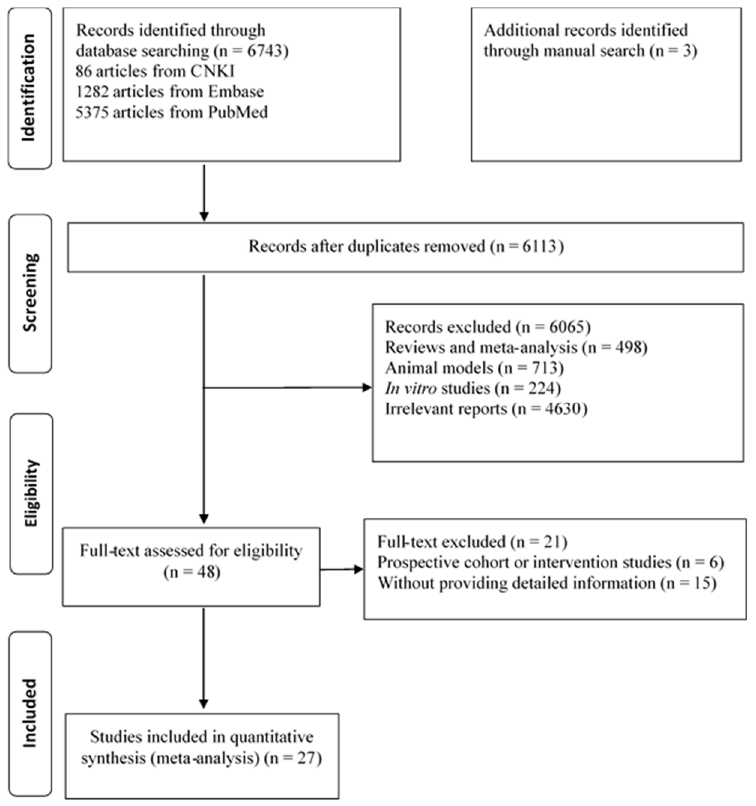
Figure 1. Flow chart of the study selection process.